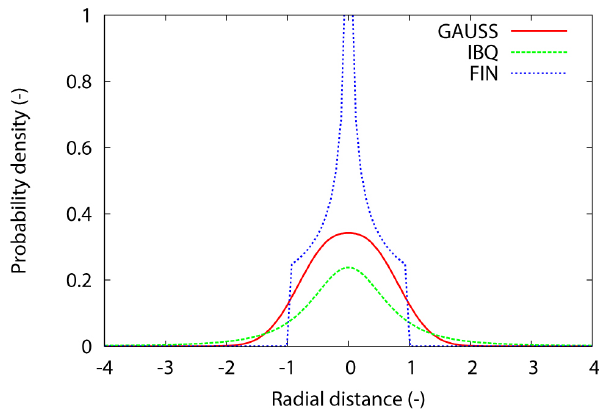
Figure 1. Probability densities of various kernel functions: the Gaussian kernel (GAUSS), the inverse bi-quadratic kernel (IBQ), and a finite kernel that vanishes in one bandwidth